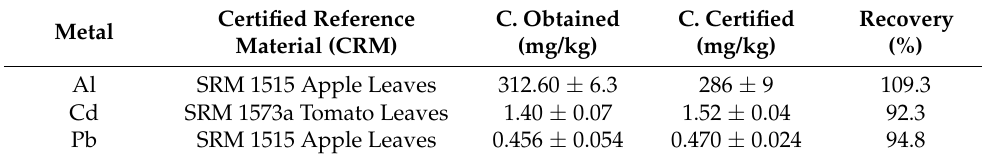
Table 4. Recovery study